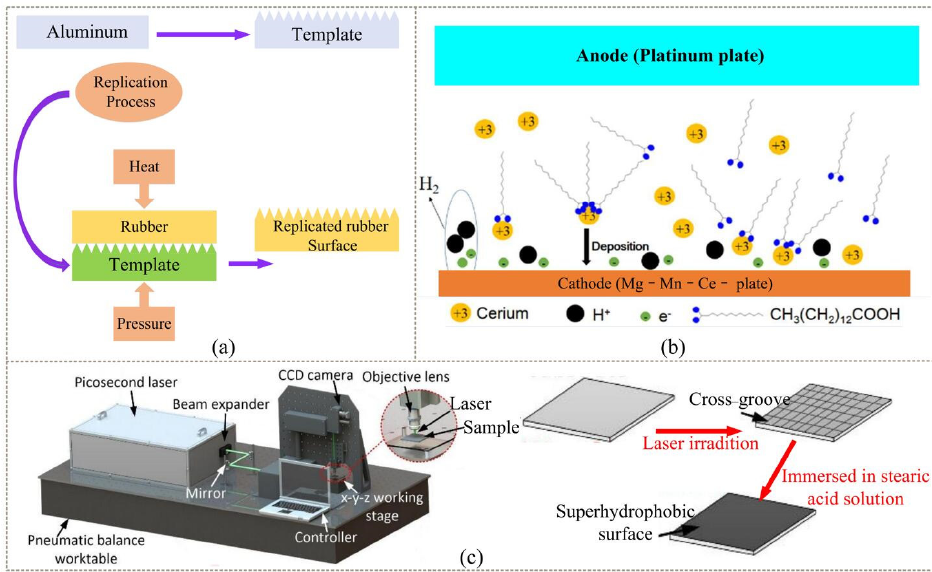
Figure 2. Preparation methods and principles of superhydrophobic surfaces: ( a ) template method [61]; ( b ) spraying method [62]; ( c ) etching method [63].